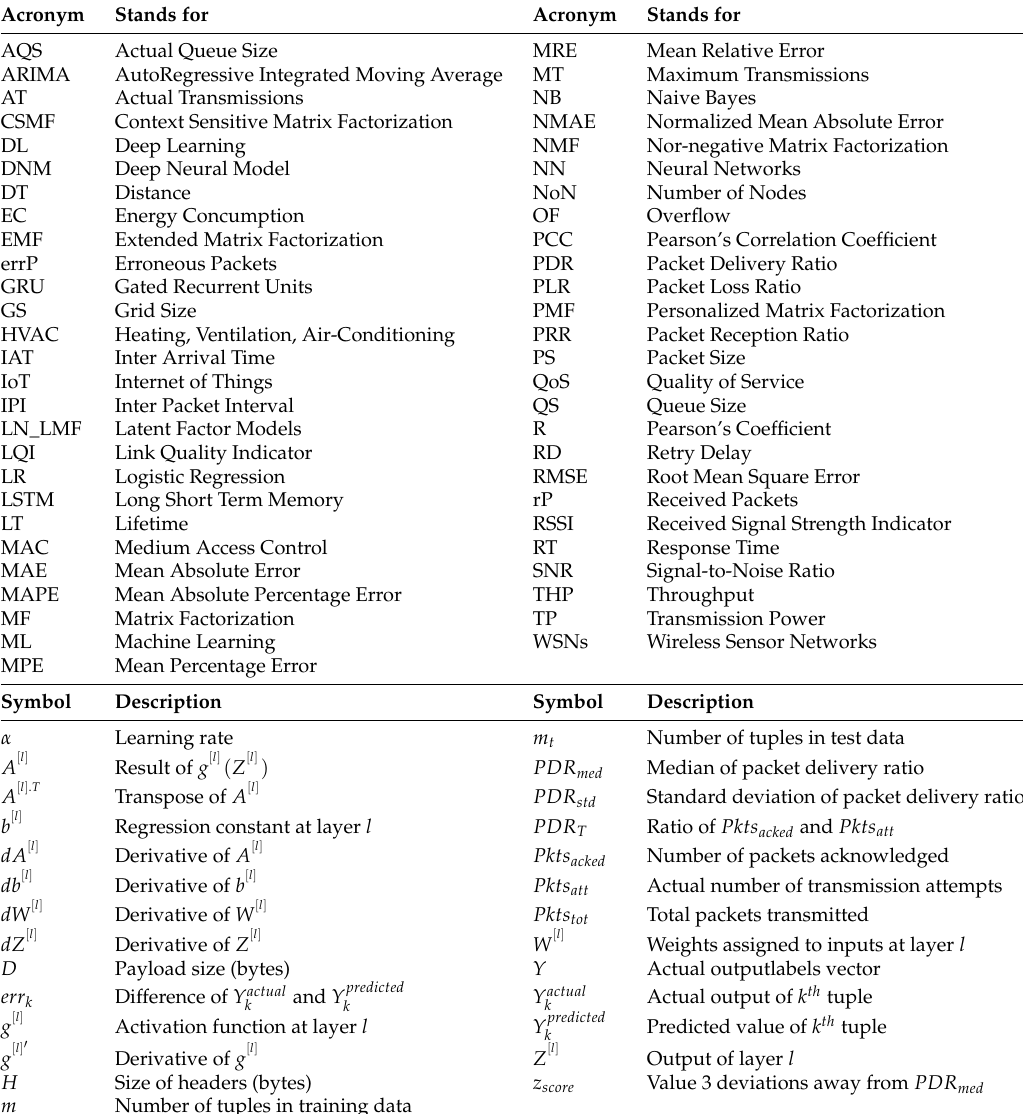
Table 2. List of acronyms and symbols used in this text.